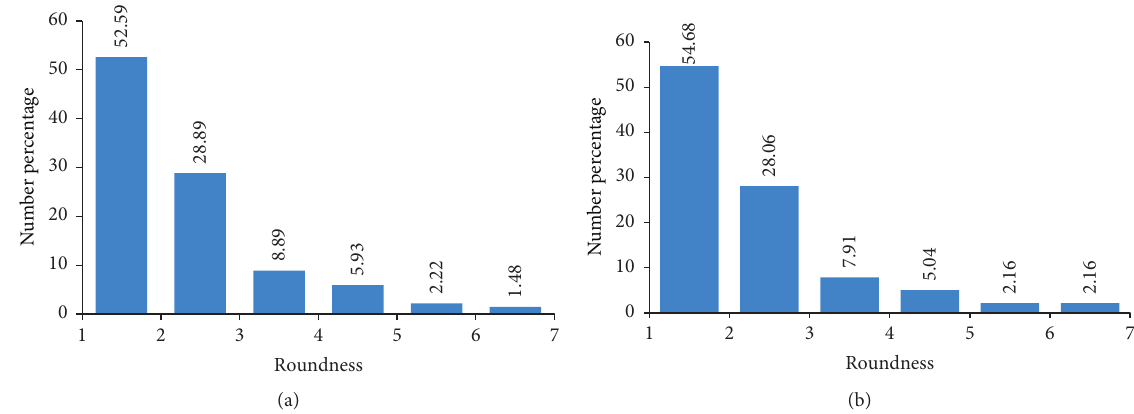
Figure 10: The number of pores with different roundness: (a) specimen 1#; (b) specimen 2#.